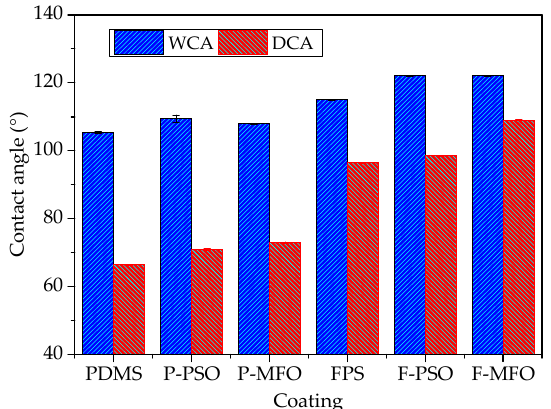
Figure 5. WCA and DCA of studied coatings.